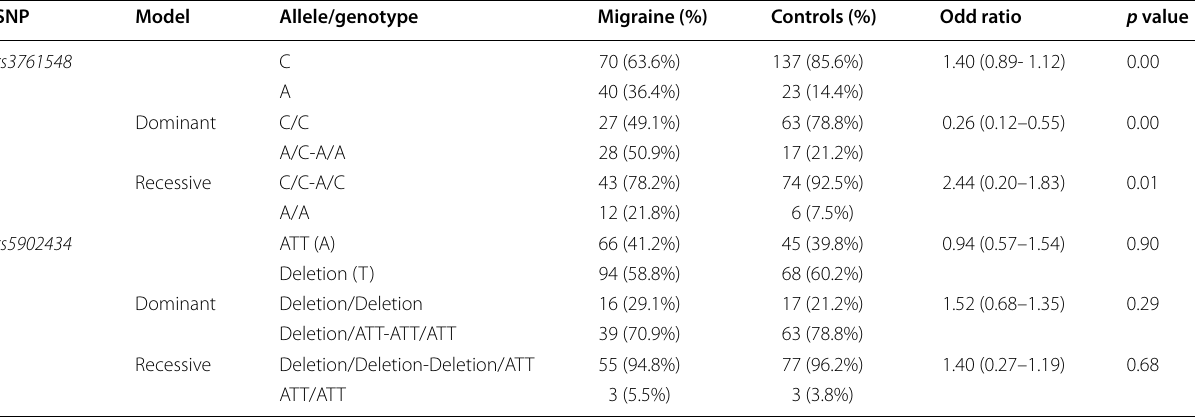
Table 3 Genotype and allele frequencies of FOXP3 rs3761548 and rs5902434 patients and control subjects in Iranian population